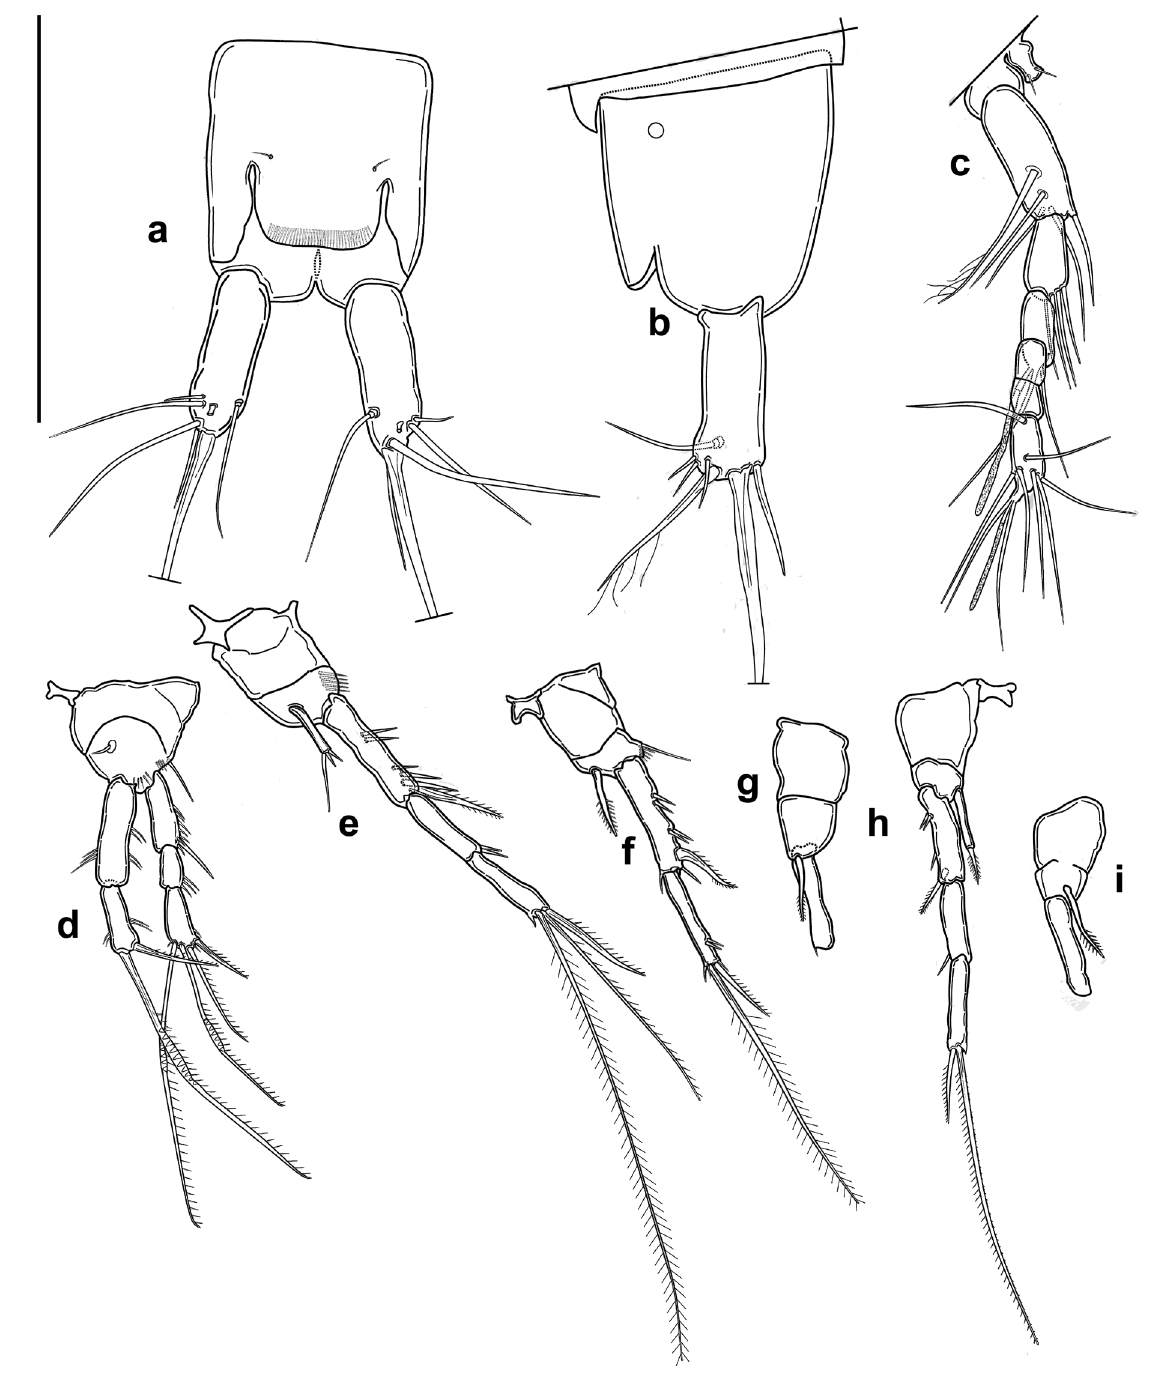
Fig. 7. Cottarellicaris sanctiangeli Bruno & Cottarelli sp. nov., ♀ (NHMUK). a . Anal somite, anal operculum and caudal rami, dorsal view (variability). b . Anal somite, anal operculum and caudal rami, lateral view (variability). c . Rostrum, A1. d . P1, anterior view. e . P2, inner view. f . P3, posterior view. g . Coxa, basis, enp P3, inner view. h . P4, posterior view. i . Coxa, basis, enp P4, inner view (variability). a, c–i: Grotta Grotta Vucco Ucciardo; b: Grotta del Banco di ferro. Scale bar: 50